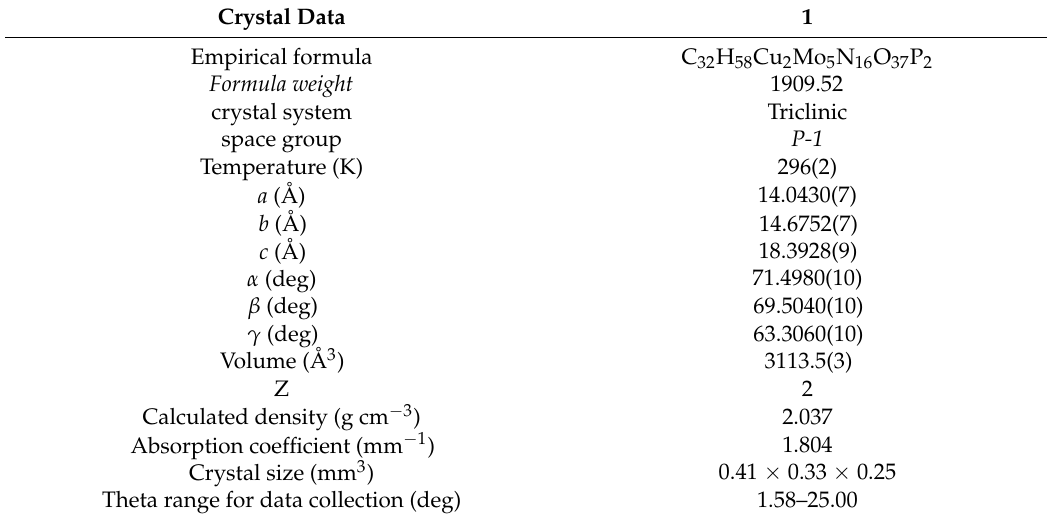
Table 1. Summary of crystal data and refinement results for compound 1